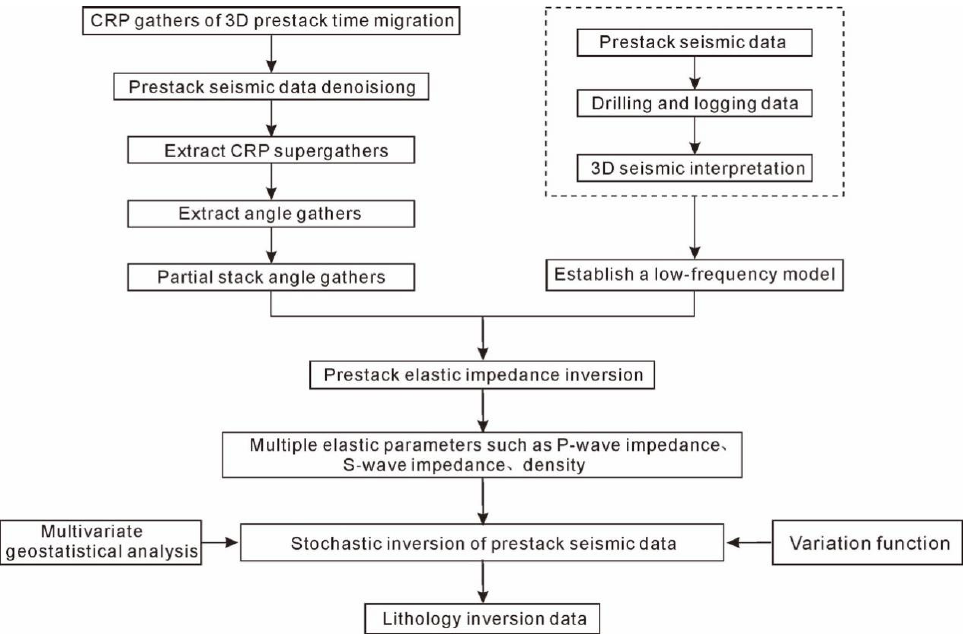
Figure 5. Flow chart of the stochastic prestack inversion technique used in the present study.